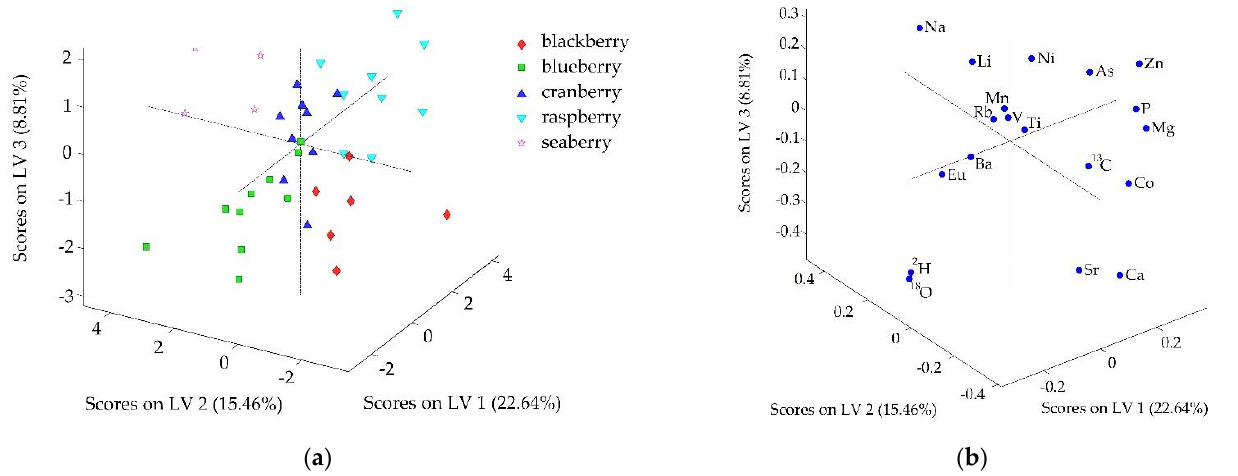
Figure 6. PLS-DA score ( a ) and loading plot ( b ) associated with the differentiation of berries according to botanical origin.